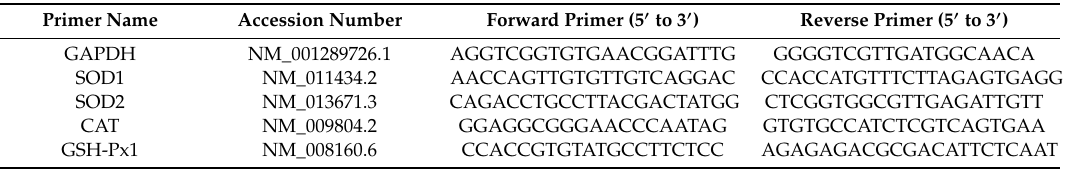
Table 2. The sequences of primers used in the current